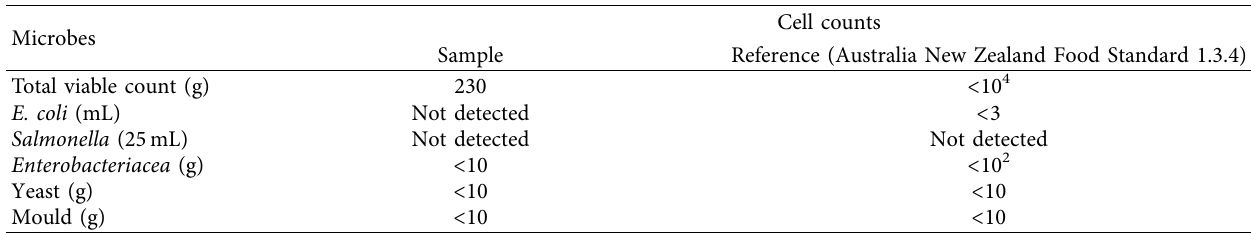
Table 4: Microbiological test (cfu/ml) of grape kombucha.